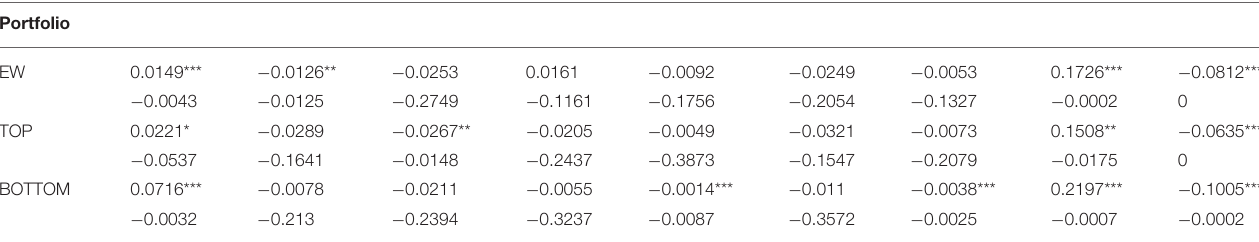
TABLE 4 | Linear regression results based on all